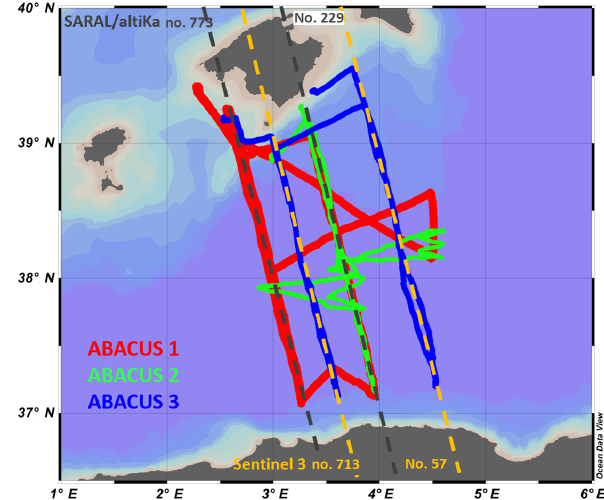
Figure 2. Glider tracks during the missions: ABACUS 1 (red dots), ABACUS 2 (green dots) and ABACUS 3 (blue dots). The devia- tions from the monitoring line were undertaken to sample some mesoscale structures identified through near-real-time satellite al- timetry and SST maps. The ground tracks of the SARAL/AltiKa (grey dashed lines) and Sentinel-3 (yellow dashed lines) satellites over the study area are also